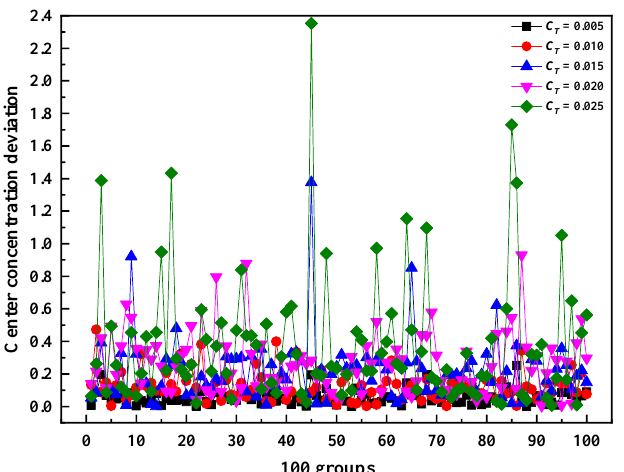
Figure 13. Center concentration deviation under the different relative standard deviations of temperature at velocity 1.35 m/s.